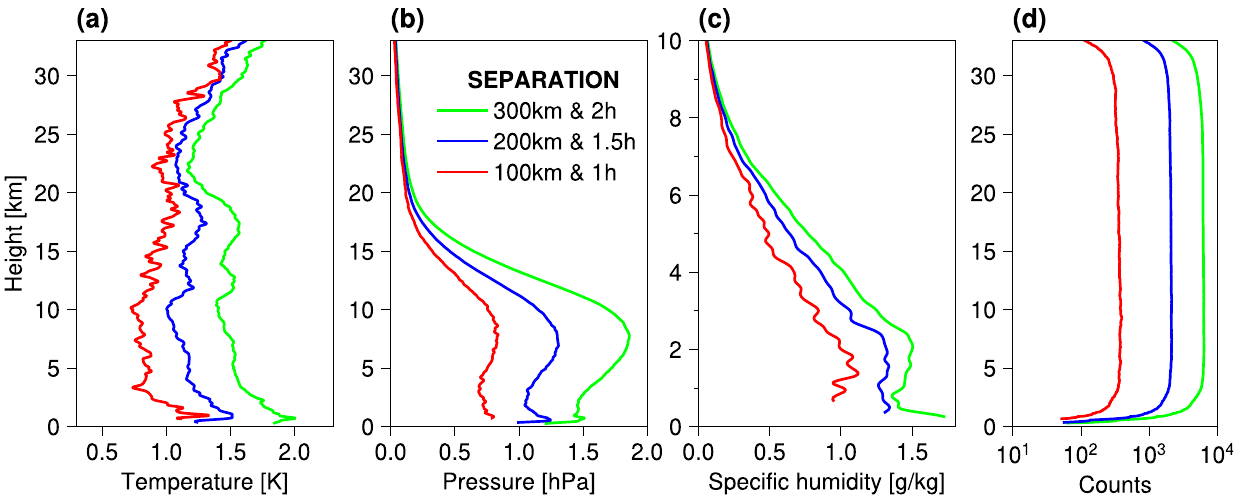
Figure 15. Standard deviations of NEW minus RS92 for different collocation thresholds (see legend): ( a ) temperature (°C), ( b ) pressure (hPa), ( c ) specific humidity (g kg −1 ), and ( d ) data counts. Results on near-surface heights are not shown when the data counts are less than 50.